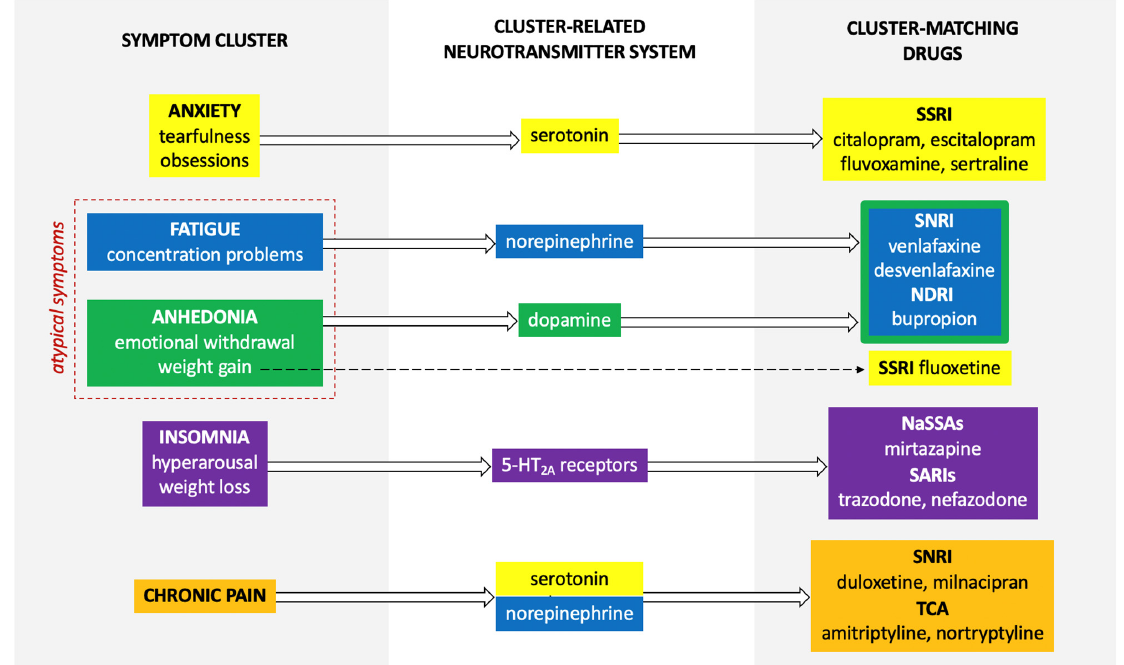
Figure 1. Relation between possible symptom origin and choice of drug. Anxiety symptoms are related to the serotonin deficiency syndrome, fatigue is associated with the norepinephrine deficiency syndrome, and anhedonia is associated with the dopamine deficiency syndrome. Dysregulation in the brain stem, related to 5-HT2A receptors is responsible for insomnia symptoms. Pain is mediated by both serotonin and norepinephrine, potentiating the effect of the endogenous opioid system. Drugs matching the system clusters are supposed to be more effective in the treatment of depression sub- type with the predominance of the specific symptom cluster (based on Lin et al. [11]). SSRI—selective serotonin reuptake inhibitors; SNRI—serotonin norepinephrine reuptake inhibitors; NDRI—norepinephrine dopamine reuptake inhibitors; NaSSAs—noradrenergic specific serotonergic antidepressants; SARIs—serotonin antagonist reuptake inhibitors; TCA— tricyclic antidepressants.